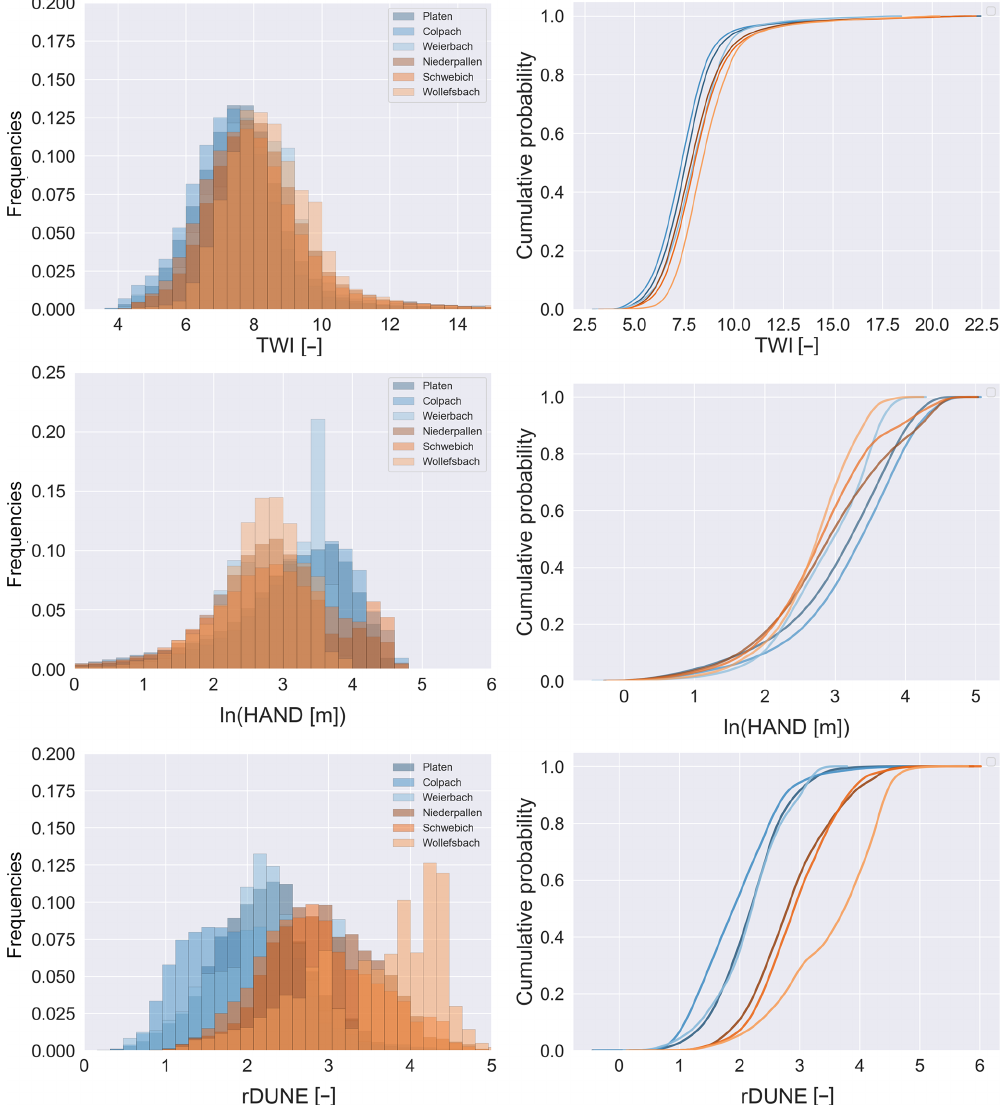
Figure 3. Frequency distributions and cumulative density functions of the TWI, ln(HAND) and rDUNE for the six research catchments. In blue are the schist catchments (Platen, Colpach and Weierbach), and in green are the marl catchments (Schwebich, Niederpallen and